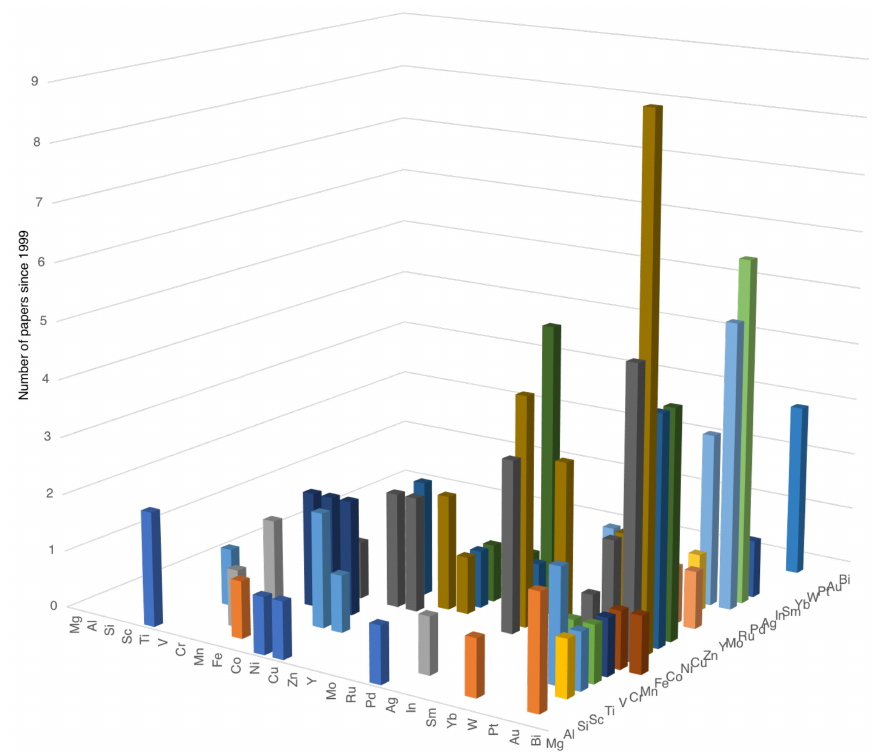
Figure 4. Two-element nanoparticle systems reported since 1999. When looking for a particular combination, search along the line of the lighter